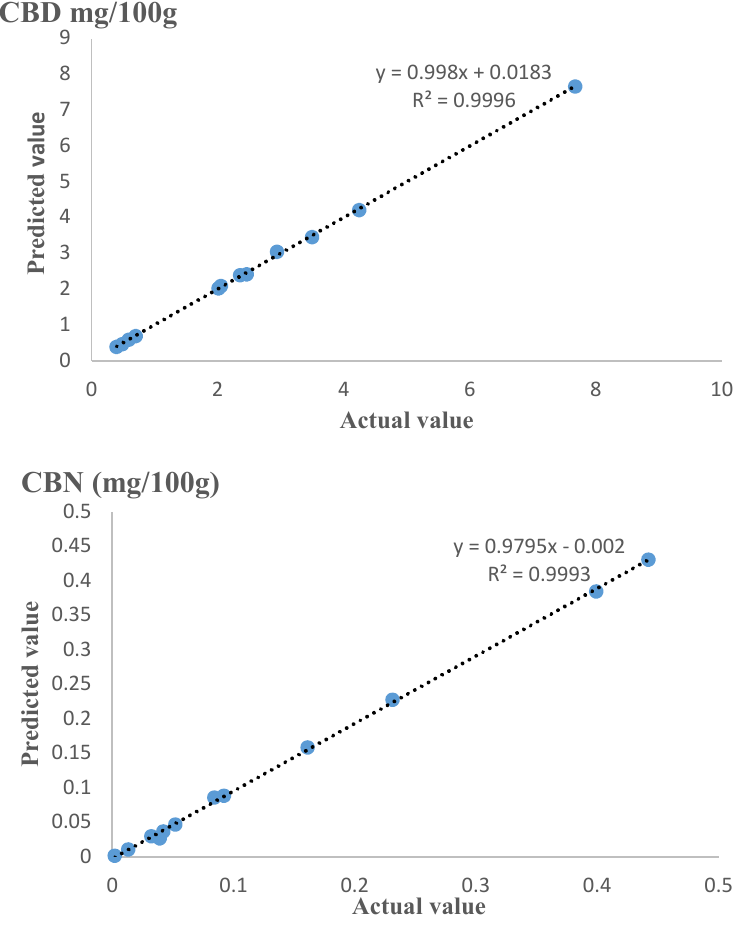
Figure 1. Predicted vs. actual values of cannabinoid responses.